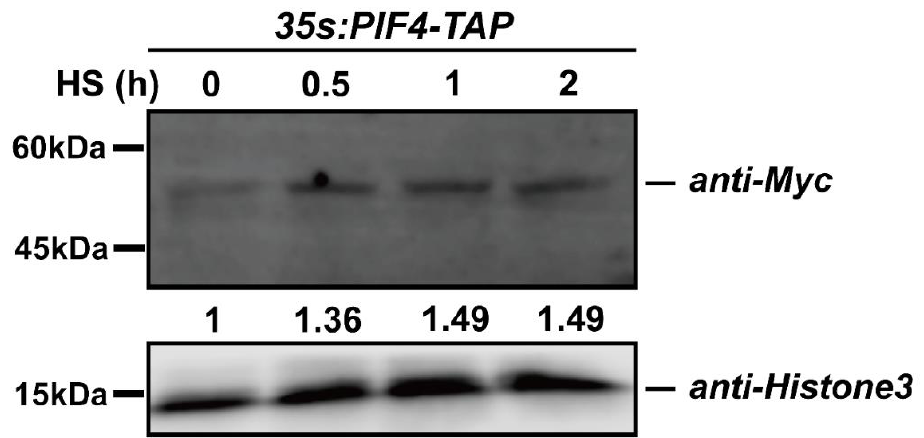
Figure 6. The protein accumulation of PIF4 under heat stress conditions. Detection of the PIF4 protein levels in 4-day-old 35S:PIF4-TAP/WT seedlings grown in darkness and in the seedlings transferred to 45 ◦ C for 0.5, 1, and 2 h. The proteins were detected by immunoblot analysis using an anti-Myc antibody.